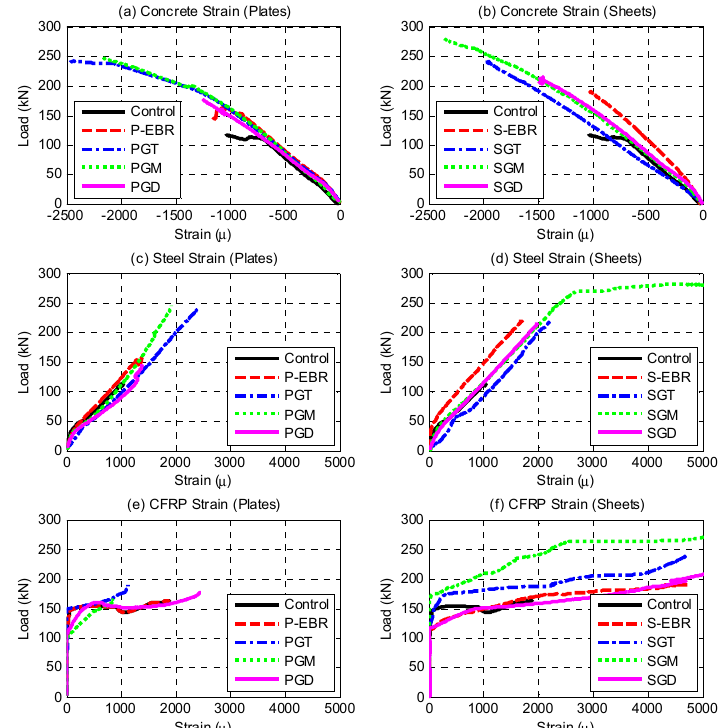
Figure 13. Load-strain relationships for concrete, steel and CFRP laminates: ( a ) Concrete strain (Plates); ( b ) Concrete strain (Sheets); ( c ) Steel strain (Plates); ( d ) Steel strain (Sheets); ( e ) CFRP strain (Plates); ( f ) CFRP strain (Sheets).